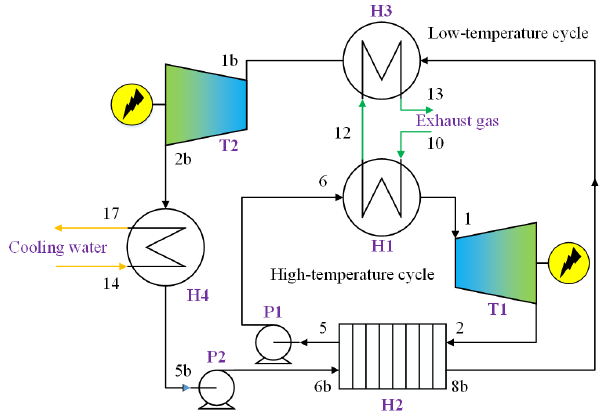
Figure 1. Flow diagram of dual-loop organic Rankine cycle (DORC) system.